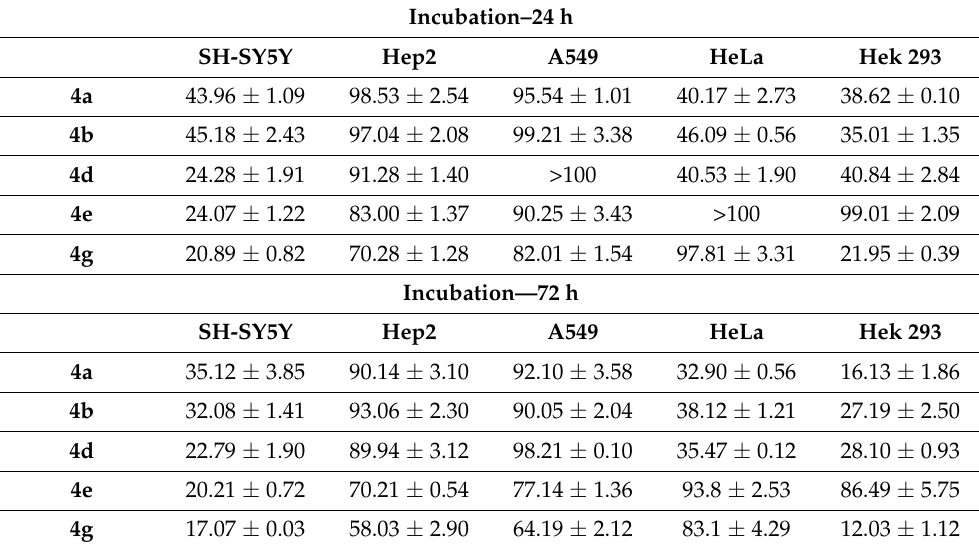
Table 4. Cytotoxic potential of water-soluble salts based on